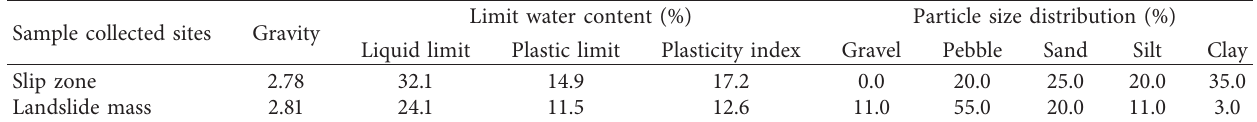
Table 1: Limit water content and particle size distribution for soil samples collected at slip zone and landslide mass.